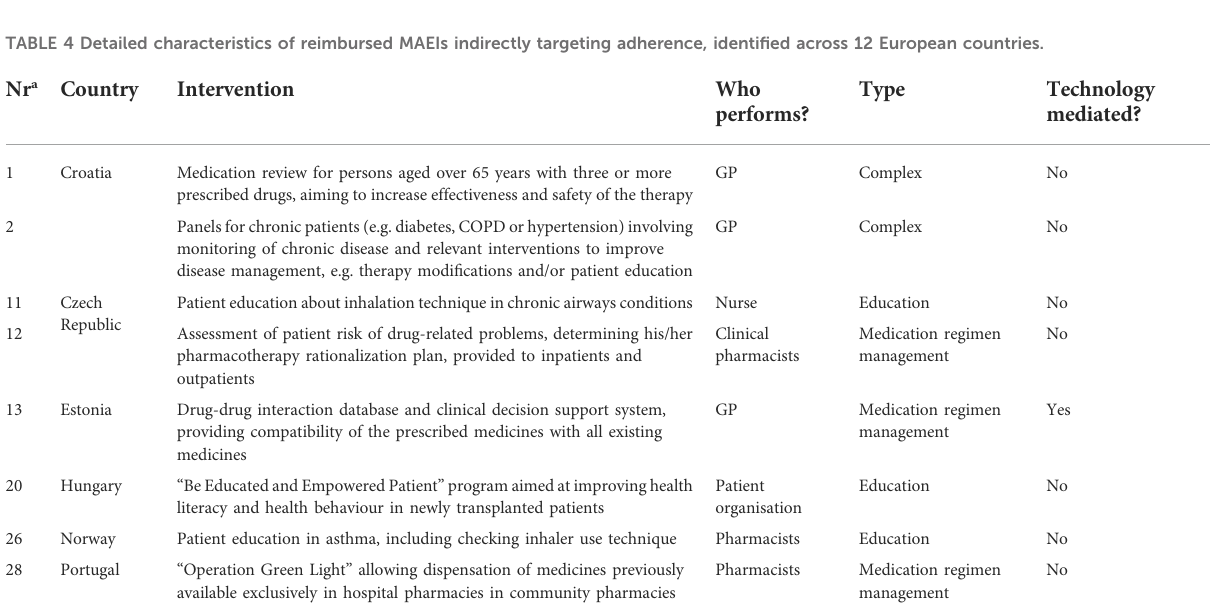
TABLE 4 Detailed characteristics of reimbursed MAEIs indirectly targeting adherence, identi fi ed across 12 European countries. Nr a Country Who